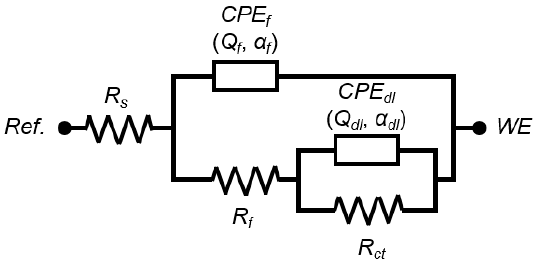
Figure 8. Equivalent electrical circuit used to model the experimental EIS data of the Al-Si-Fe-Cu-Zn (-Co, -Ni) alloys [34–36].